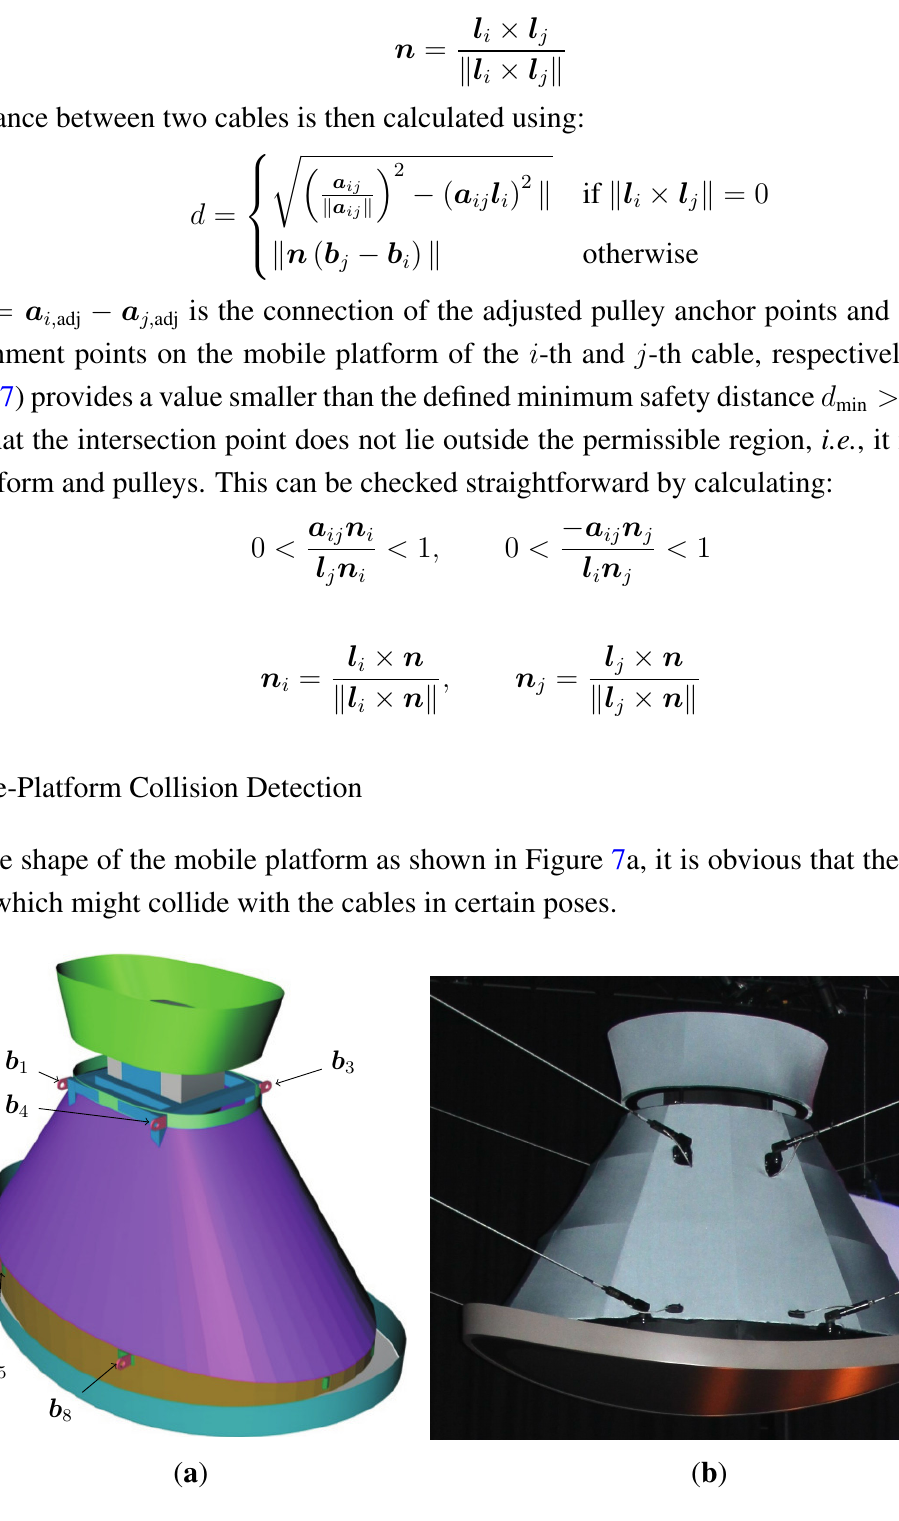
Figure 7. Designed mobile platform of the cable robot: ( a ) CAD rendering of the mobile platform design used at the EXPO show with the marking of the visible cable attachment points and the final mobile platform; ( b ) the platform of a cable robot in the German Pavilion at the EXPO